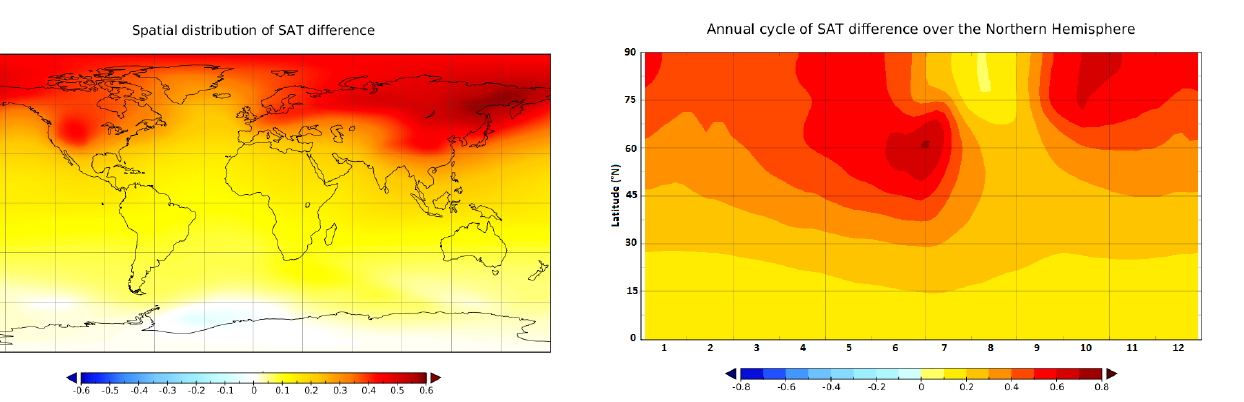
Fig. 4. Annually-averaged spatial distribution of the difference in temperature (EXT-CTL) averaged over the 500th year of the climate model simulation.